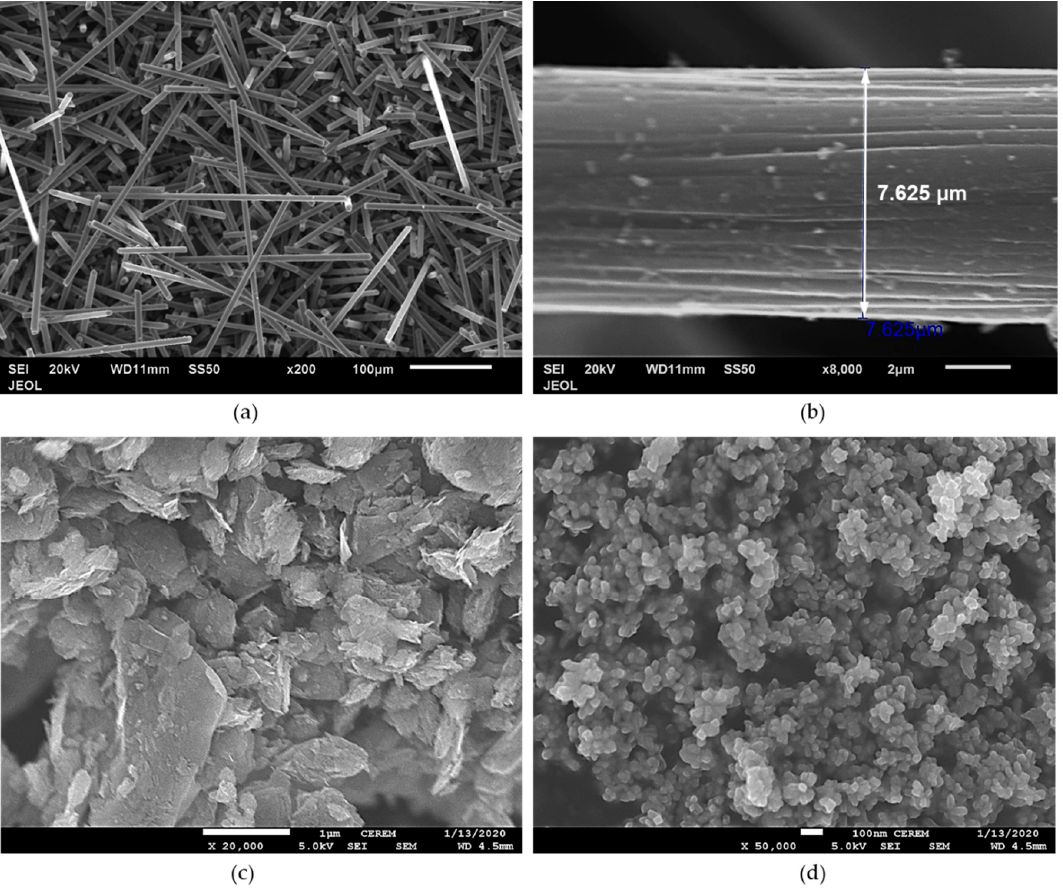
Figure 2. SEM images of raw materials ( a , b ) short carbon fiber at different magnifications, ( c ) graphite nano-platelet, ( d ) titanium dioxide nanoparticles.